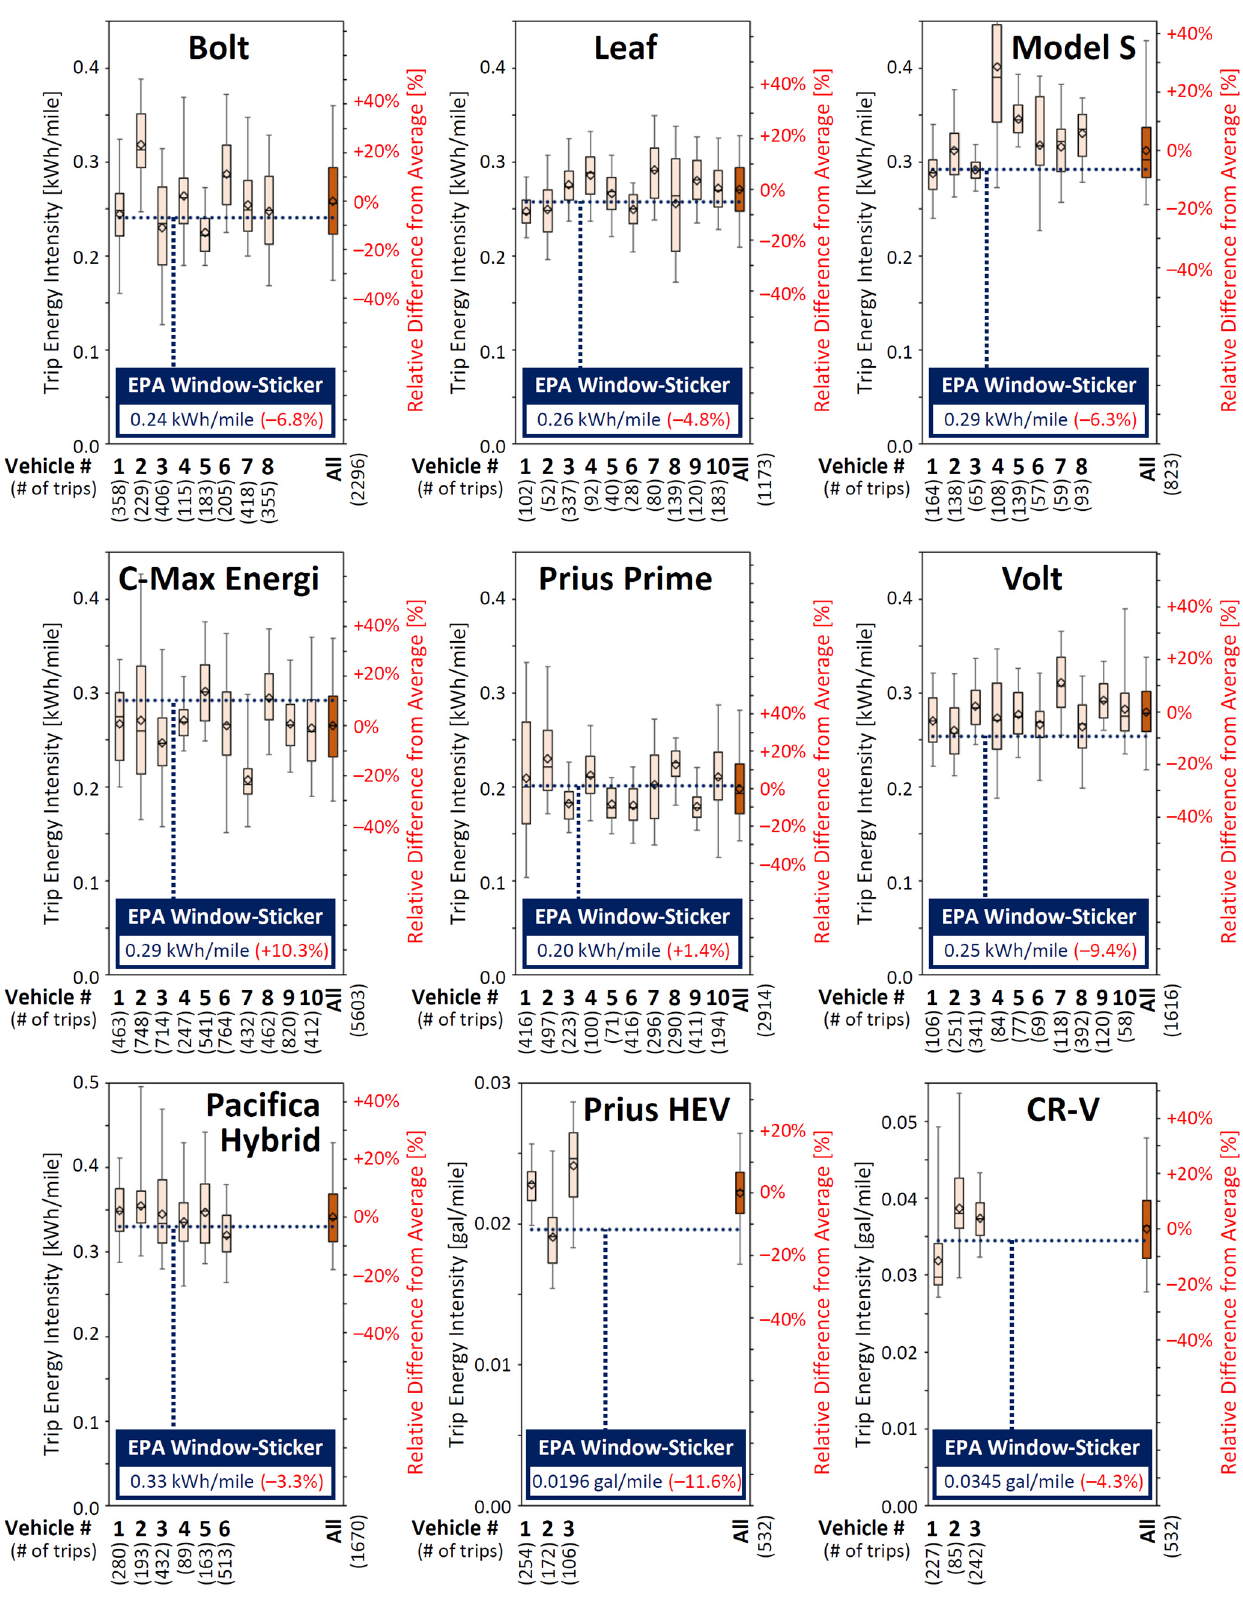
Figure 1. Baseline estimated costs of CICE and various plug-in vehicle models for 2018 and 2030.